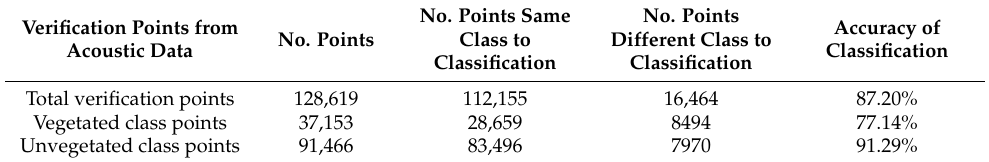
Table 1. The classification-accuracy assessment performed using verification points from acoustic data.